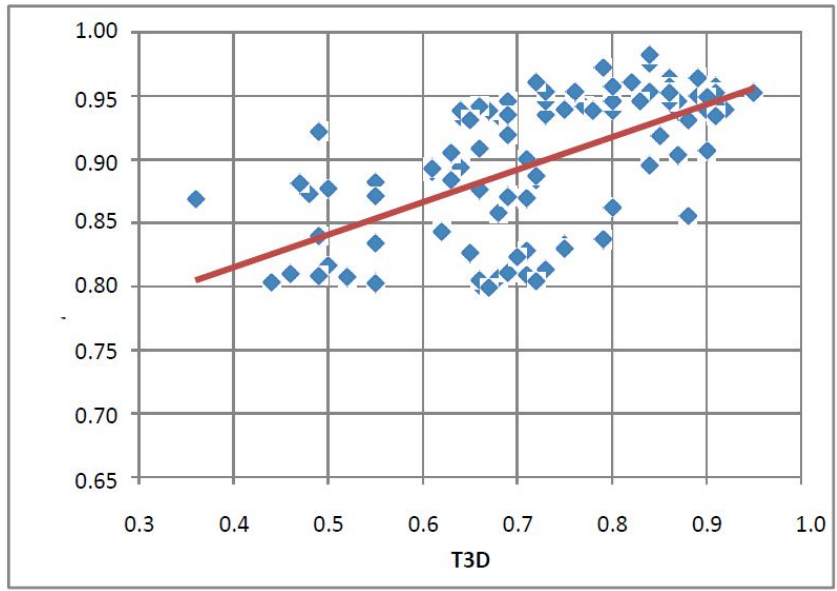
Figure 2. Correlation between T2D and T3D values of the compounds (104) selected for the second round